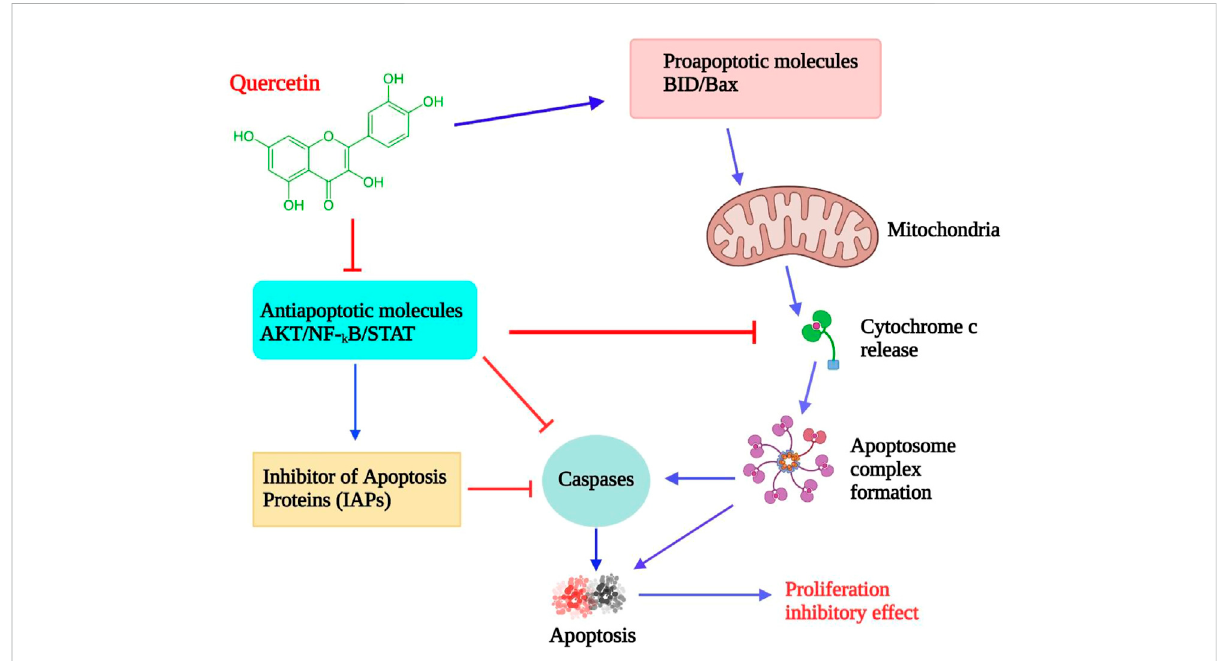
FIGURE 5 Effects of quercetin on lymphoma cells: proposed model. By inhibiting antiapoptotic signaling molecules and inducing proapoptotic proteins, which activate mitochondrial-mediated caspase activation and apoptosis, quercetin reduces cell proliferation (GULATI et al., 2006; Srivastava et al.,